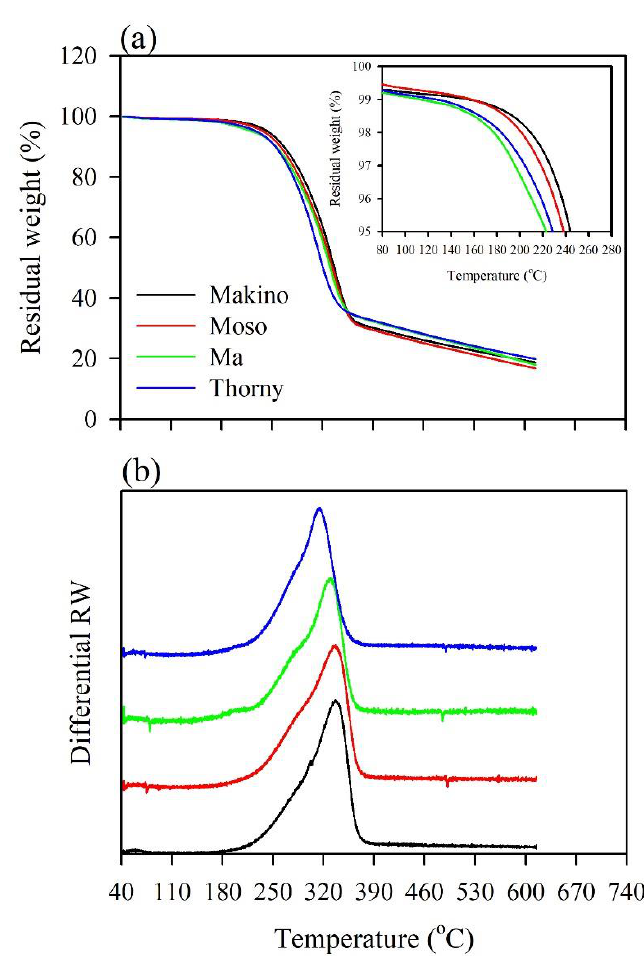
Figure 2. Thermogravimetric (TG) curves of various BFs at a heating rate of 5 °C/min. ( a ) Residual weight (RW) curves; ( b ) differential RW curves.